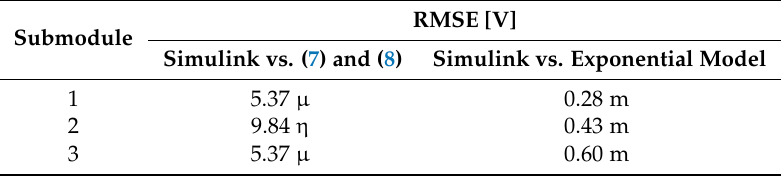
Table 3. Errors in the reproduction of the I-V curve under simulation scenario 1.